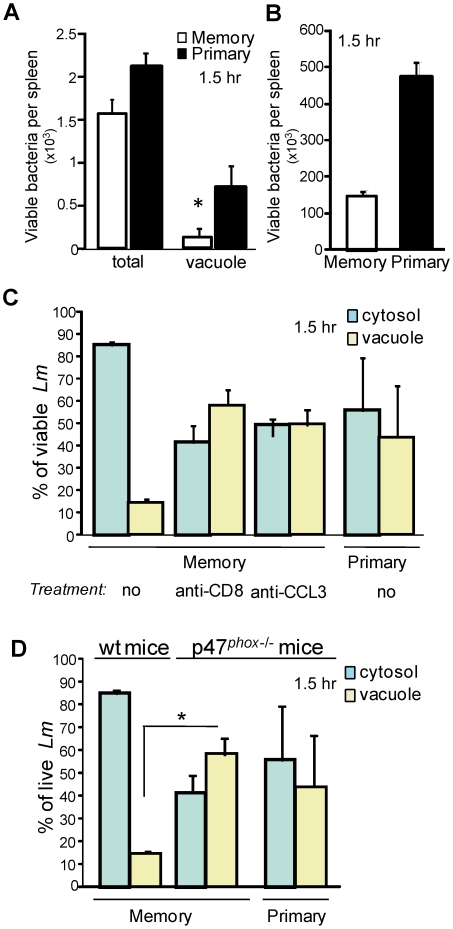
Early killing of Lm requires ROI and takes place inside the vacuoles of phagocytes from secondary infected mice.Primary and memory mice (9–12/group) were challenged one month later with 3×105 wt-L029 Lm unless otherwise indicated. 1.5 hr post-infection, spleen cells treated or not with chloramphenicol, lysed and plated. (A) shows the number (mean +/− SE) of Lm CFUs recovered from the spleen. In (B), primary and immune mice (4–5/group) were challenged with 2×108 ΔLLO Lm. The number of Lm CFUs (mean +/− SE) per spleen is shown in a pool of 2 experiments. In (C), primary and memory mice (4–6/group) were treated or not with anti-CD8 or anti-CCL3. Histograms show the frequencies (mean +/− SE) of cytosolic (blue bars) and vacuolar (yellow bars) Lm CFUs in phagocytes in a pool of 2 experiments. In (D), primary and memory p47phox
−/− and wt C57BL/6 mice (5–6/group) were challenged with 3×105 wt-L029 Lm. Histograms show the frequencies (mean +/− SE) of cytosolic (blue bars) and vacuolar (yellow bars) Lm CFUs in phagocytes in a pool of 2 experiments (n = 5).